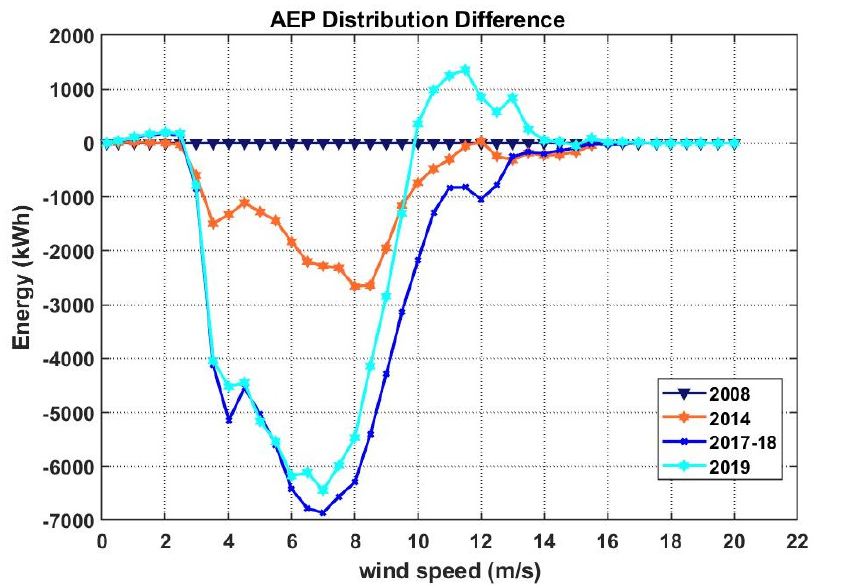
Figure 10. AEP variations compared to 2008 reference